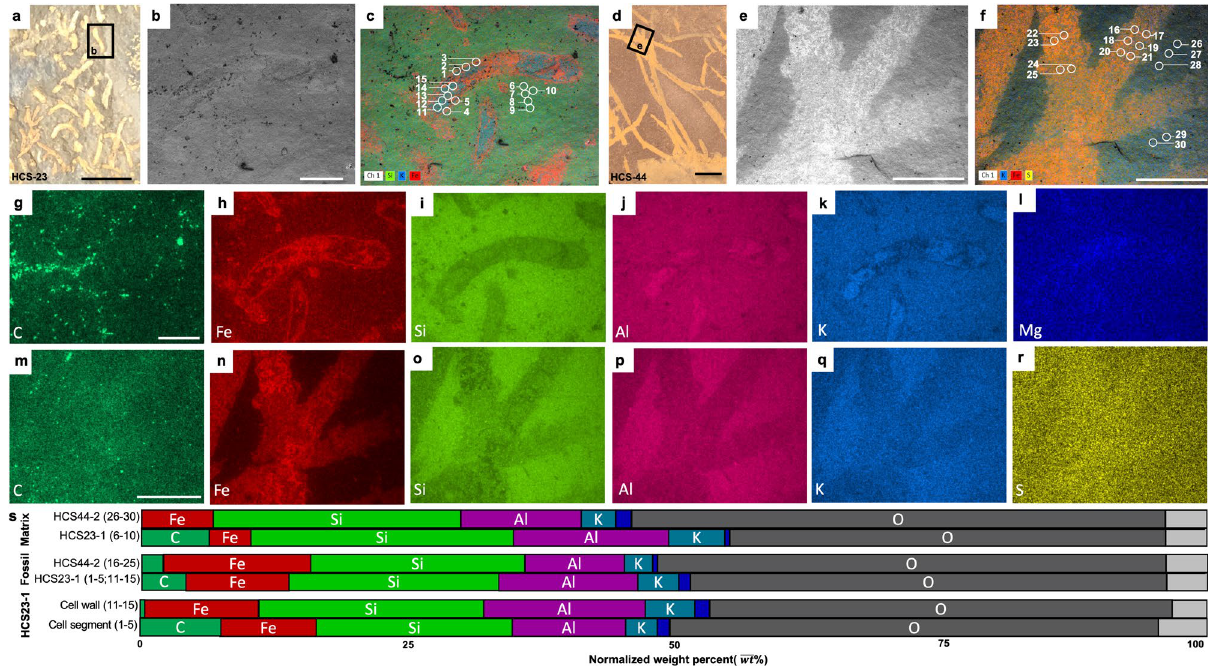
Figure 4. Grade 3: Poorly preserved macroalgae. ( a ) Reflected light image of HCS-23. ( b ) SEM BSE image of ( a ) (rectangle). ( c ) BSE image with EDS overlay of ( a ) showing the locations of sampled point data and distribution of Si, K, and Fe. ( d ) Reflected light image of HCS-44. ( e ) SEM BSE image of ( d ) (rectangle). ( f ) BSE image with EDS overlay of d showing locations of sampled point data and distribution of S, K and Fe. ( g – l